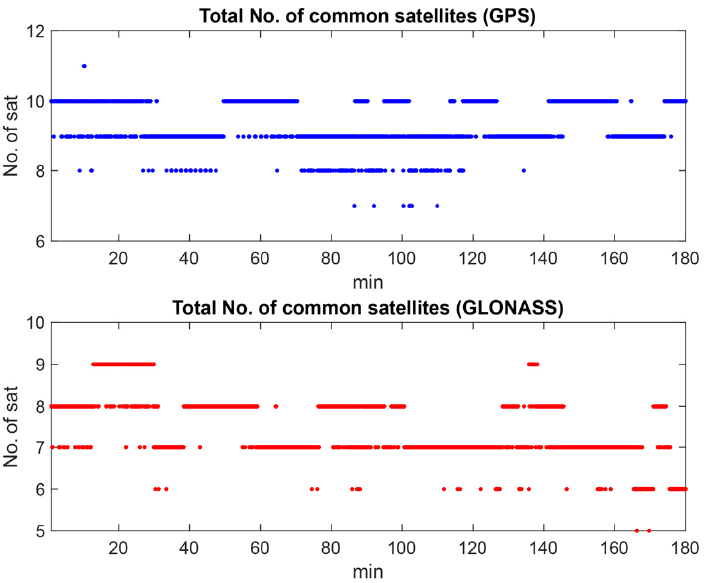
Figure 4. Total number of common GPS and GLONASS satellites between S20B and S20A on L1 frequency.